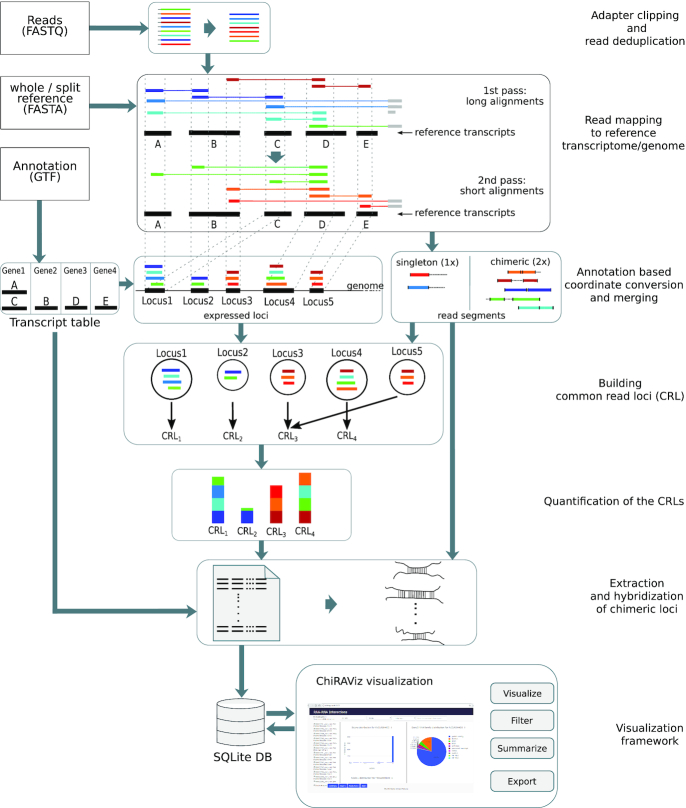

ChiRA workflow. First, the reads are deduplicated and mapped to reference sequences. Then the overlapping reference regions are merged into expressed loci. Given an annotation file, transcriptomic alignment positions are converted into genomic positions. Common read loci are built on the basis of the reads that are consistently multi-mapped among the expressed loci. The quantification is carried out at the common read loci level, and the interactions are scored and hybridized. With the visualization, users can search, filter, and export preferred interactions. Here transcripts A and C are 2 isoforms of a gene Gene1. Because of shared exons, multi-mappings to A and C can be collapsed into a single genomic locus Locus1. As Locus3 and Locus5 share all their read segments, they are merged into a single CRL. Owing to the quantification based on expectation maximization, the multi-mapped green read segment is counted more towards CRL1 than CRL2.